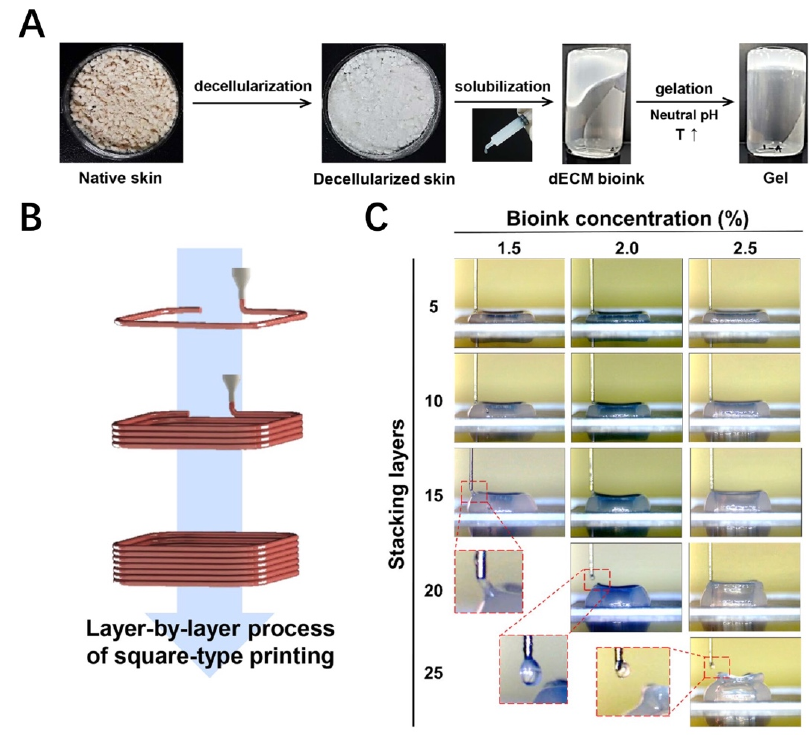
Figure 9. The fabrication of skin-derived collagen bioink and the 3D stacking process [178] . ( A ). The fabrication of skin-derived collagen bioink. ( B ). 3D stacking process. ( C ). 3D stacking with different